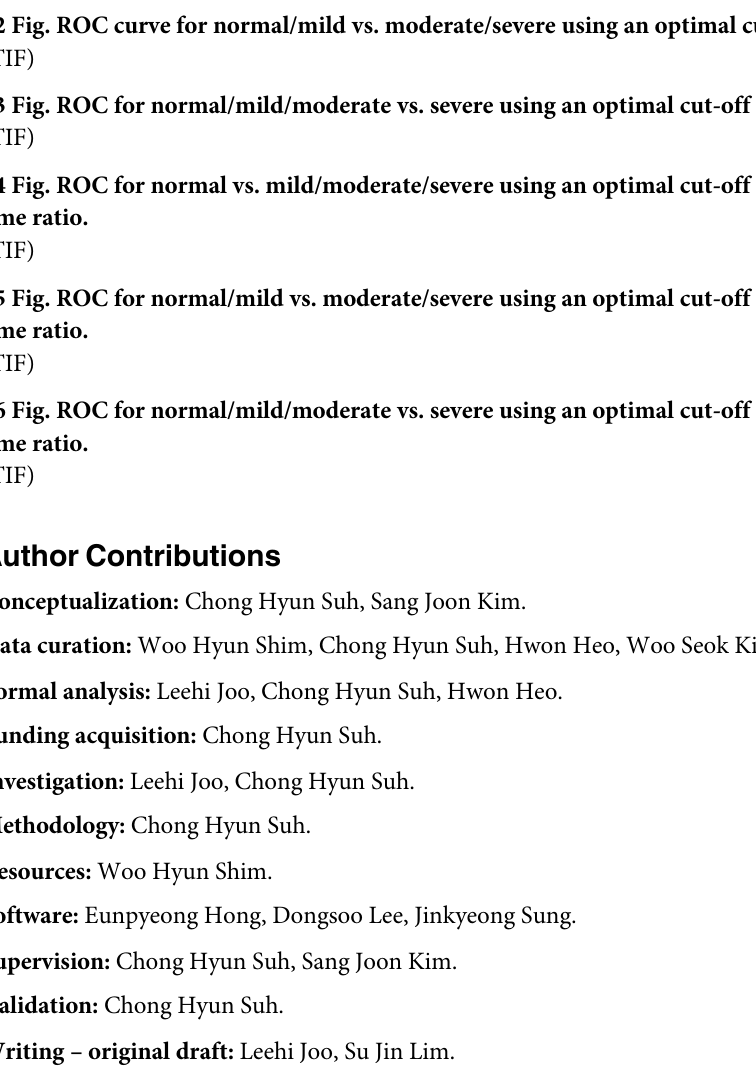
S2 Fig. ROC curve for normal/mild vs. moderate/severe using an optimal cut-off of WMH. (TIF) S3 Fig. ROC for normal/mild/moderate vs. severe using an optimal cut-off of WMH. (TIF) S4 Fig. ROC for normal vs. mild/moderate/severe using an optimal cut-off of WMH vol- ume ratio. (TIF) S5 Fig. ROC for normal/mild vs. moderate/severe using an optimal cut-off of WMH vol- ume ratio. (TIF) S6 Fig. ROC for normal/mild/moderate vs. severe using an optimal cut-off of WMH vol- ume ratio.